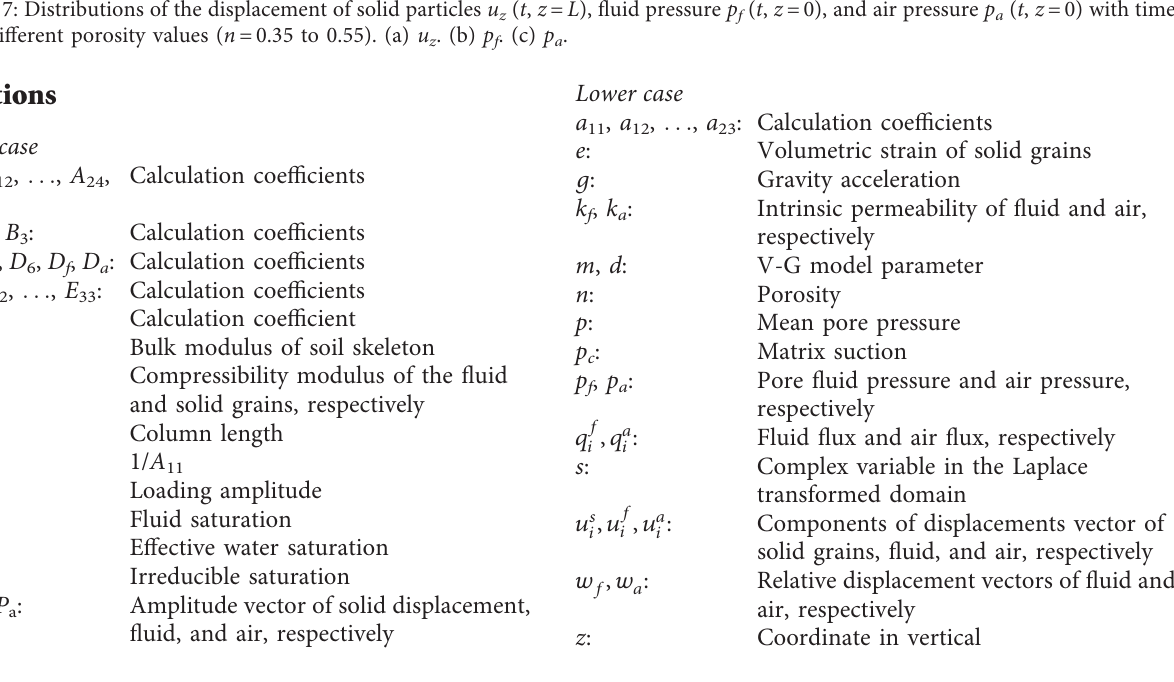
� L ), fluid pressure p � 0), and air pressure p � 0) with time z ( t , z f ( t , z a ( t , z